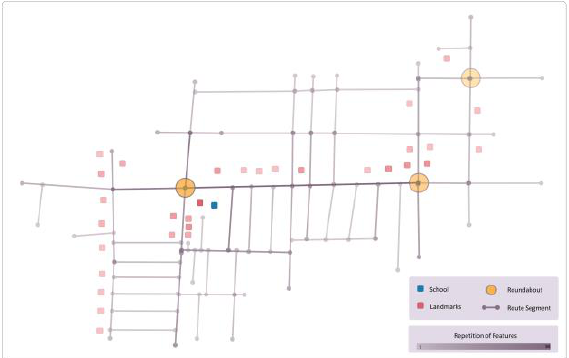
Figure 4. Sample output of the